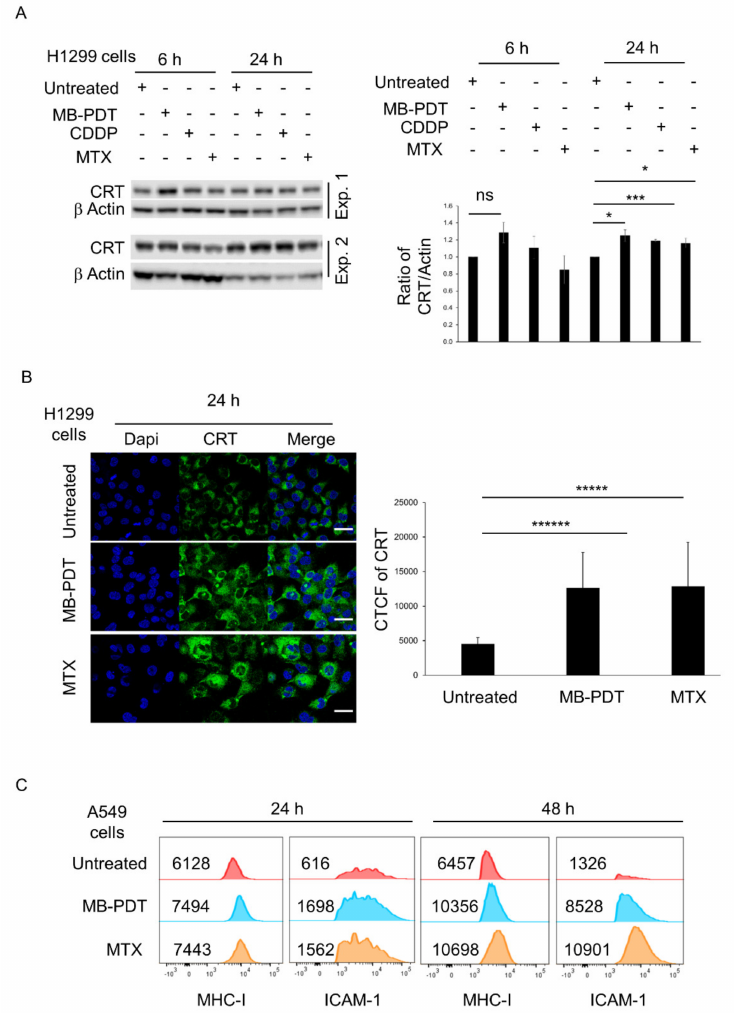
Figure 3. MB-PDT increases the expression of calreticulin and immunogenic cell death markers in lung cancer cells. ( A ) Immunoblotting of CRT expression in H1299 cells treated with MB-PDT (20 µ M) for 6 and 24 h. Densitometry of immunoblotting of two experiments is presented on the right. * p < 0.05, *** p = 0.003. ( B ) Representative immunofluorescence images of CRT in MB-PDT- treated H1299 cells 24 h post-treatment. The corrected total cell fluorescence (CTCF) of CRT is presented on the right. Significance determined by two tailed Student’s t -test. ***** p = 2.1 × 10 − 5 , ****** p = 6.9 × 10 − 8 . Images were acquired on a SP8 confocal microscope. Scale bar: 45 µ m. ( C ) The expression of MHC-I and ICAM-1 was analysed by flow cytometry in A549 cells 24 and 48 h post- treatment. The data are presented in the histograms. The numbers (MFI) indicate the intensity of specific